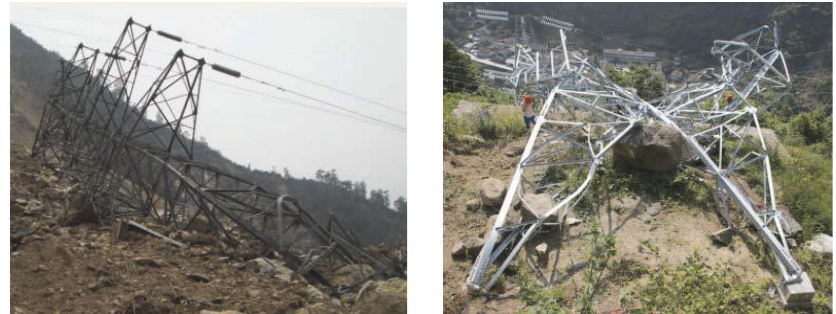
Figure 1: Collapse of transmission steel towers during Wenchuan earthquake in China